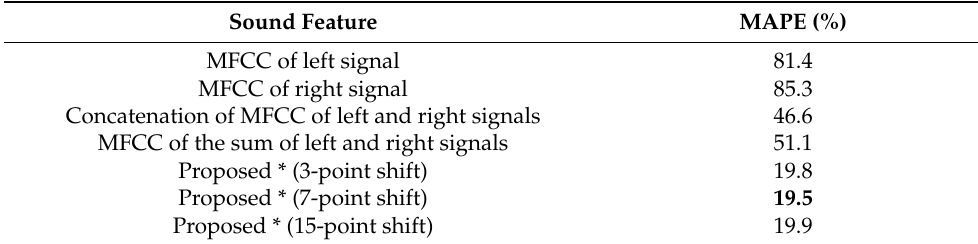
Table 3. The overall detection performance by sound feature (closed food and hybrid CTC/attention model): Five-class detection (left chewing, right chewing, front biting, swallowing, and